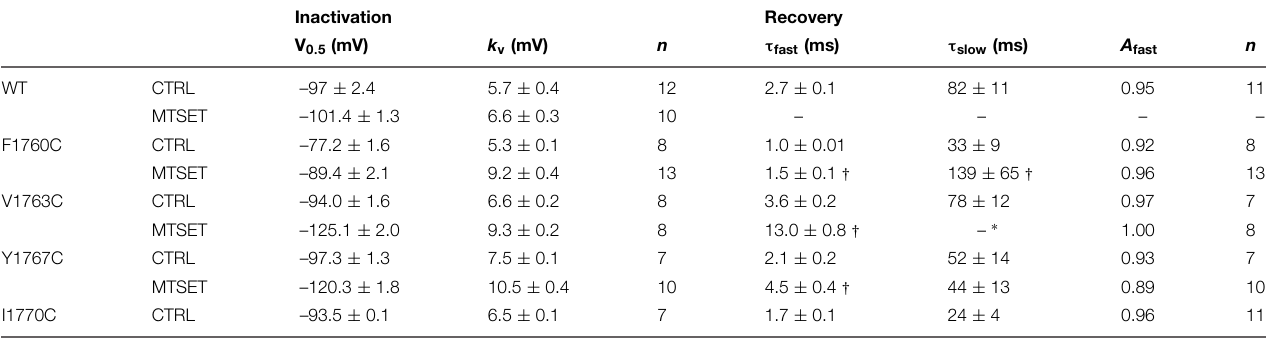
FIGURE 3 | Methanethiosulfonate reagent induces hyperpolarizing shifts in steady-state inactivation of D4S6 cysteine mutants. Steady-state inactivation was determined using 200 ms prepulses to voltages between –170 and –50 mV and a standard test pulse to –10 mV for 20 ms to assess availability. The test pulses were normalized to TABLE 1 | Biophysical properties of D4S6